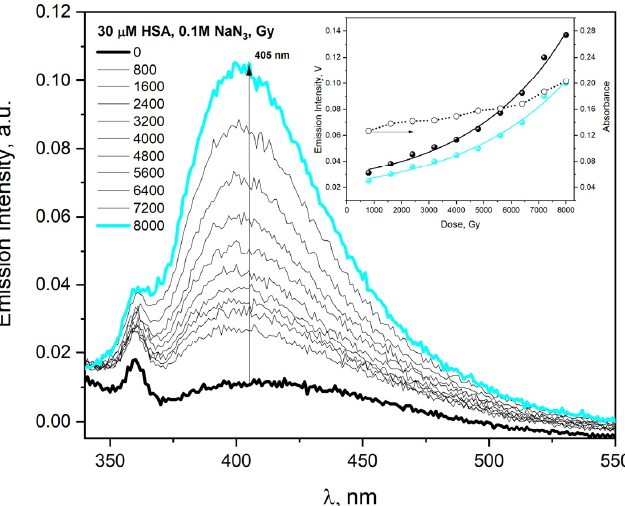
Figure 15. Emission spectra of N 2 O-saturated buffer solution of HSA (30 µM) containing NaN 3 (0.1 M), obtained for irradiation doses between 0 and 8000 Gy. The excitation wavelength was 320 nm . The arrow presented in the figure shows the increase in the intensity of the emission signal as a function of the absorbed dose. Insert : Dependence of Imax as a function of dose (0–8000 Gy) before (blue circles) and after inner filter effect correction (black circles). Dependence of Amax as a function of dose (0–8000 Gy) (white circles).